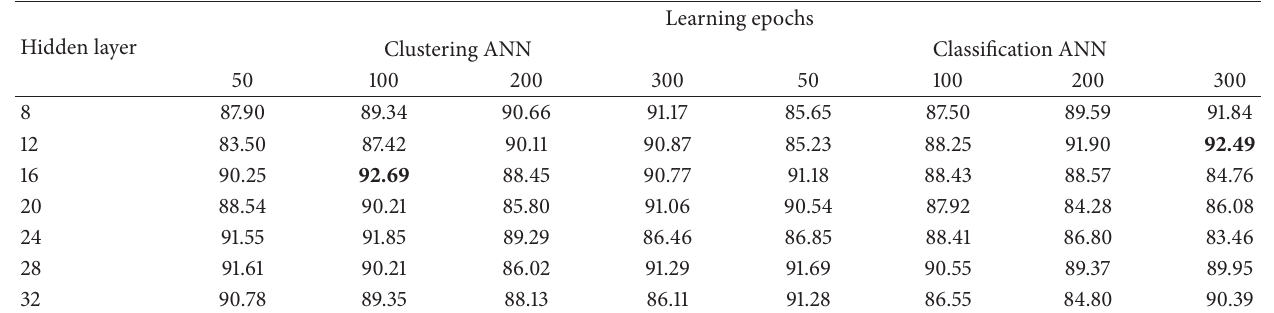
Table 3: Prediction performance of ANN + ANN hierarchical models.